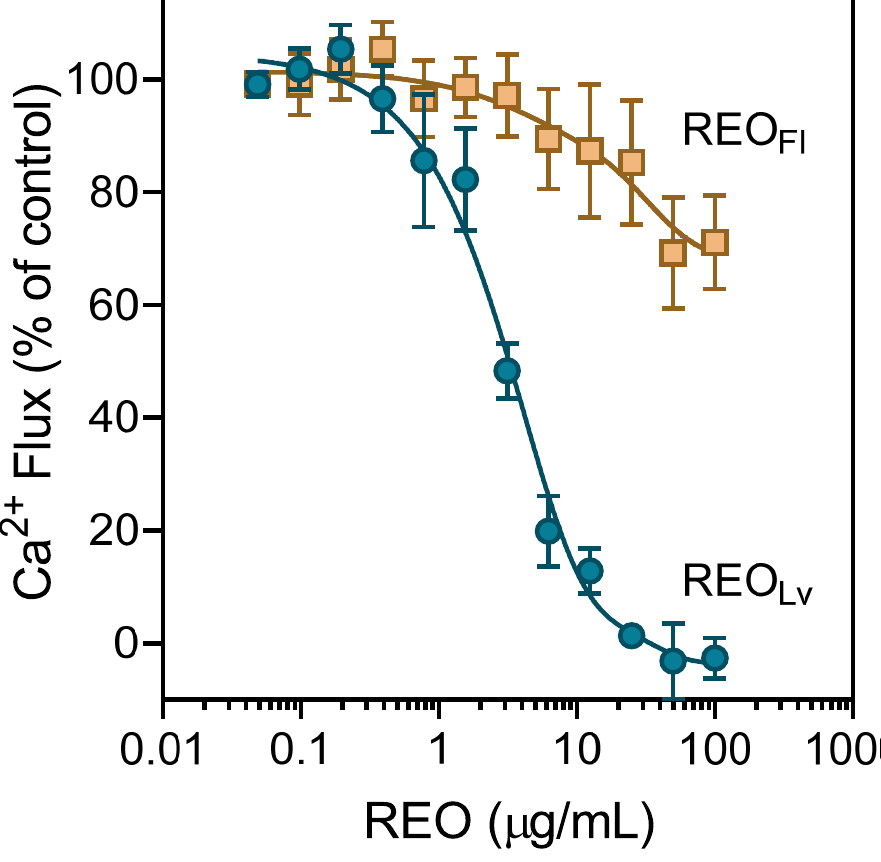
Figure 3. Effect of R. albiflorum essential oils on f MLF-induced neutrophil Ca 2+ mobilization. Human neutrophils were treated with the indicated concentrations of the REO Lv , REO Fl , or 1% DMSO (negative control) for 10 min. The cells were then activated by 5 nM f MLF, and [Ca 2+ ] i was monitored as described. The data shown are presented as the mean ± SD from one experiment that is representative of three independent experiments with similar results. Table 5. Effect of R. albiflorum essential oils and component compounds on agonist-induced func- tional responses in human neutrophils and microglial cells.